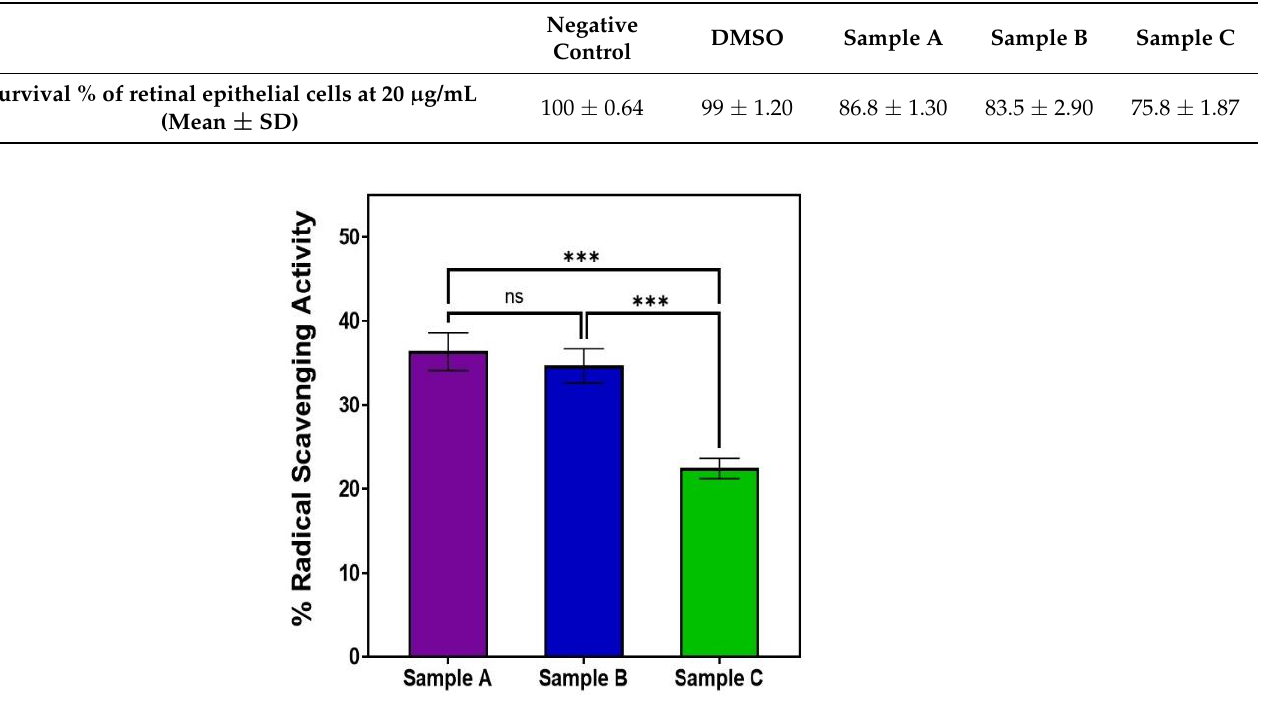
Figure 8. Bar graph comparing the free radical scavenging activity of the three samples of AuQDs